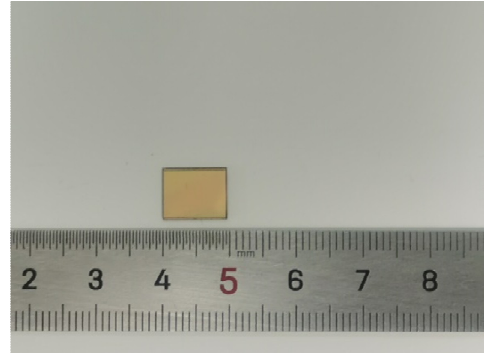
Figure 8. Photograph of the fabricated filter.